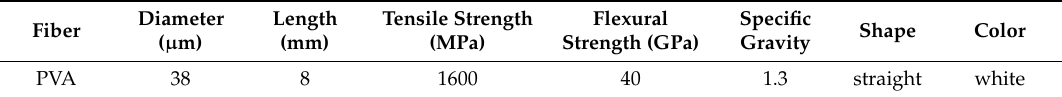
Table 1. Mechanical and physical properties of polyvinyl alcohol (PVA) fiber.